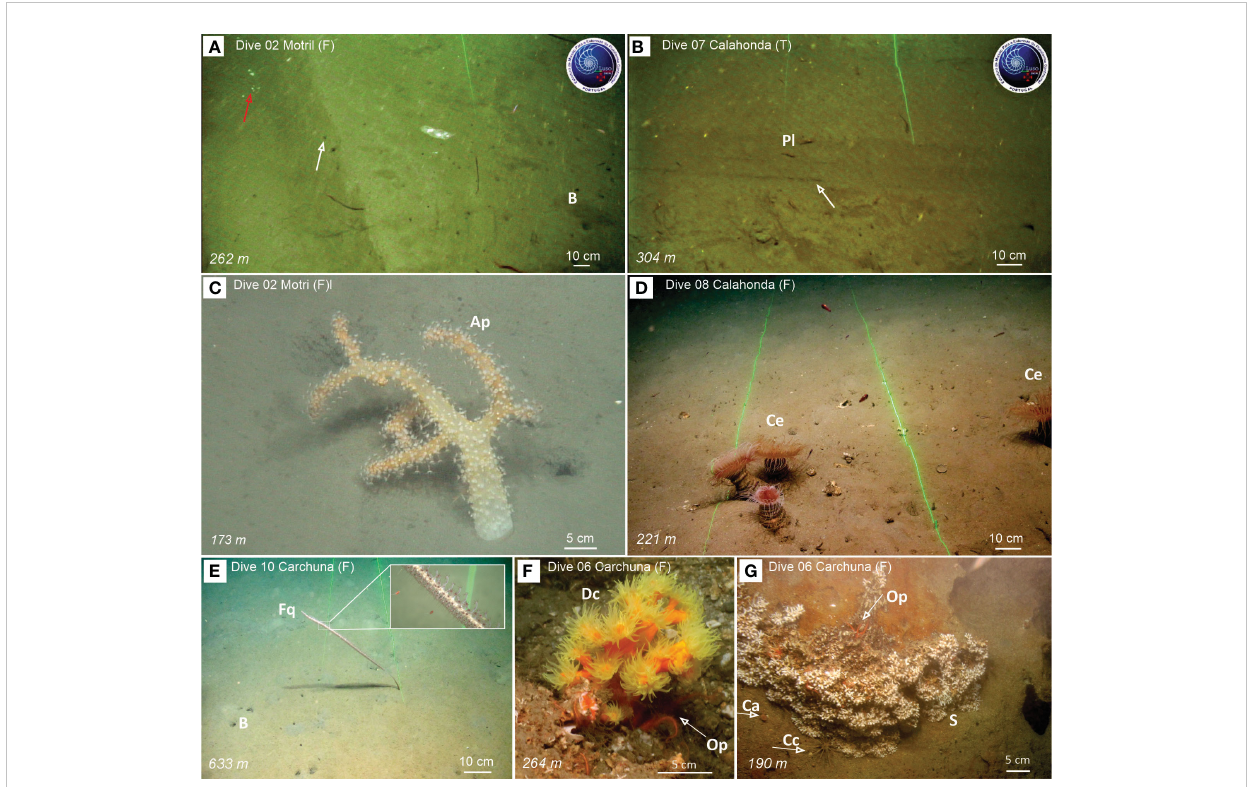
FIGURE 7 Examples of sea fl oor trawling marks observed during ROV dives along the fl ank of the Motril Canyon (A) and the thalweg of the Calahonda Canyon (B) , and benthic and demersal fauna detected in Motril (C) , Calahonda (D) and Carchuna (E-G) canyons. (A) Sea fl oor groove made by the otter board of a bottom trawling gear with broken fragments (red arrow) and a lateral mound (white arrow) on the western fl ank of the Motril Canyon. (B) Sea fl oor groove made by the otter board of a bottom trawling gear on the thalweg of the Calahonda Canyon. The bottom trawling marks seen on video footage collected by the ROV in the three submarine canyons is shown in Figure 10D. (C) The soft octocoral Alcyonum palmatum . (D) Aggregation of the cerianthiid Cerianthus sp. (E) Muddy bottoms with decapod burrows and the sea-pen Funiculina quadrangularis , with a detail of its polyps. (F) The colonial scleractinian Dendrophyllia cornigera providing shelter to the ophiurid Ophiothrix sp. (G) Aggregation of unidenti fi ed colonial scleractinians, together with solitary Caryophyllia sp. and individuals of the echinoid Cidaris cidaris and the ophiuroid Ophiothrix sp. Ap, Alcyonum palmatum ; B, Burrows made by decapods; Ca , Caryophyllia sp.; Cc, Cidaris cidaris ; Ce, Cerianthus sp.; Dc, Dendrophyllia cornigera ; Fq, Funiculina quadrangularis ; Op, Ophiothrix sp.; Pl, Plesionika sp.; S, unidenti fi ed colonial